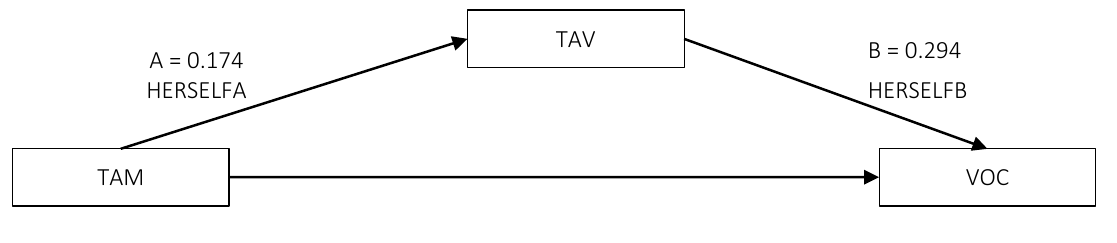
Figure 1. Mediator model